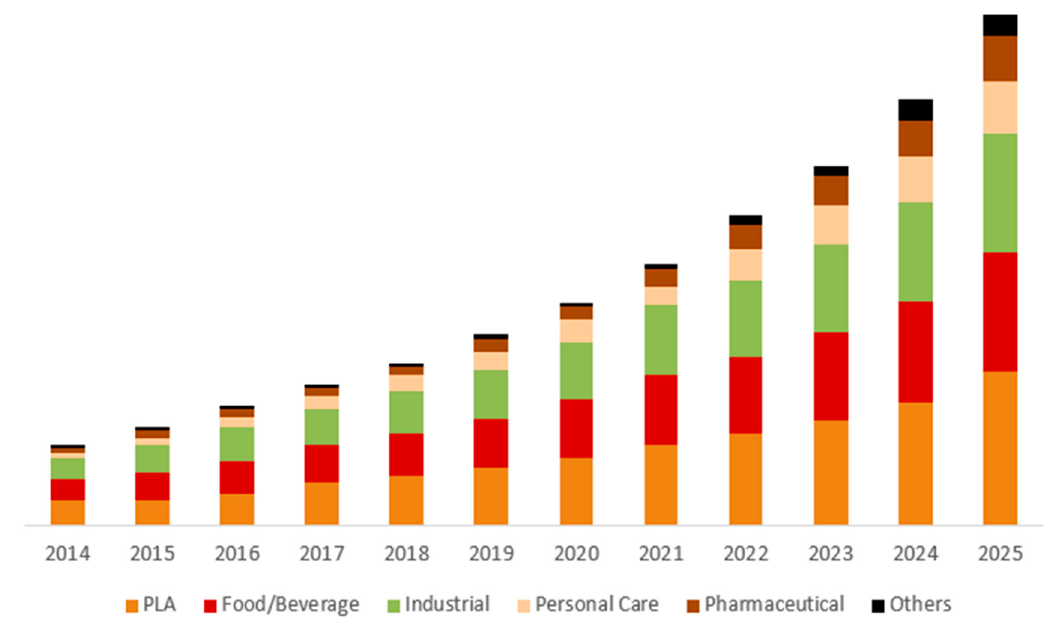
Figure 2. The forecast of the U.S. lactic acid market by application, 2014–2025 (USD Million) [38].